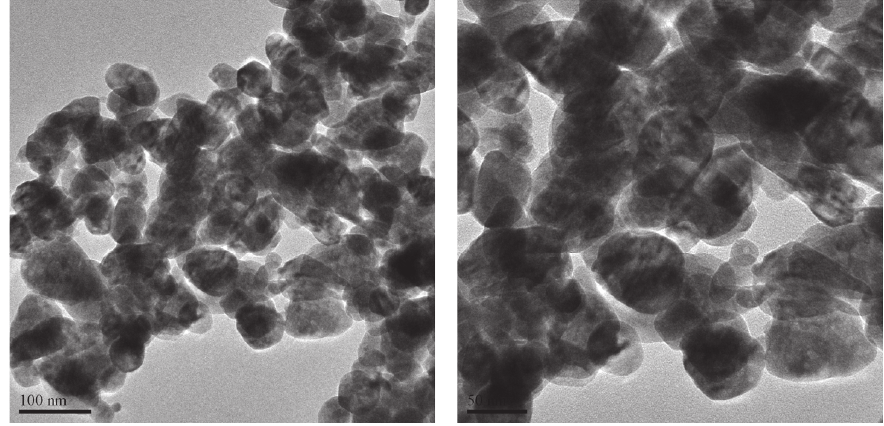
Figure 1: TEM images of ZnO